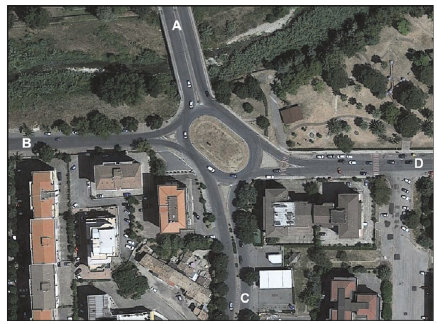
Figure 2: Aerial image of Cosmai